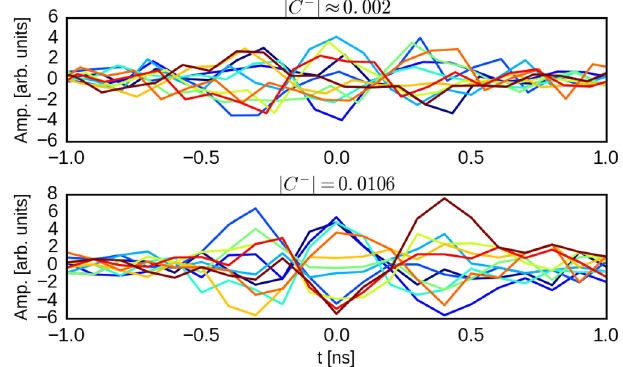
FIG. 11. Headtail monitor acquisitions during an instability without coupling (top) compared to the instability observed with coupling (bottom). 2 nodes in the headtail motion can clearly be seen in both cases. For both sets of measurements, ð Q 0 x ; Q 0 y Þ ¼ ð 9 ; 9 Þ with the transverse feedback operating in nominal conditions. FIG. 10. Top: Horizontal and vertical tunes as a function of time. Bottom: Horizontal BBQ amplitude vs time. An instability ¼ 283 A in the LOs. The tune separation developed despite J oct was calculated using the measured j C − j .